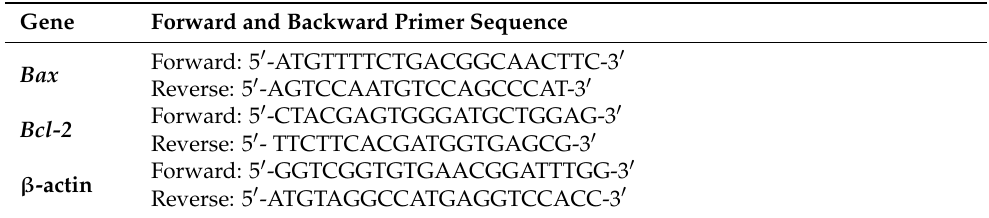
Table 2. List of primer sequence sets of Bcl-2 , Bax and β -actin used for qPCR analysis in rat